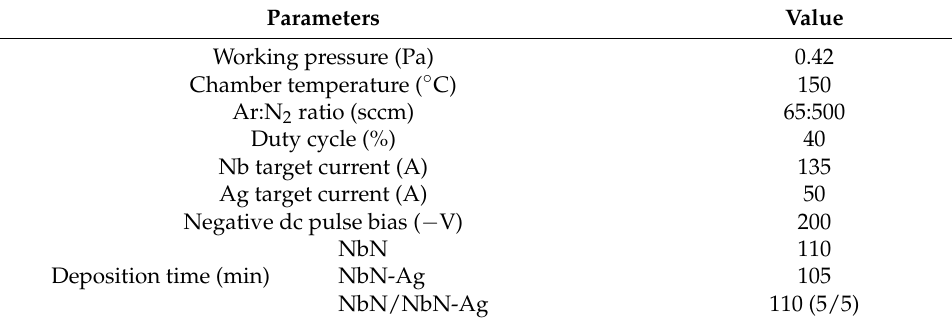
Table 1. The deposition parameters of the studied films.